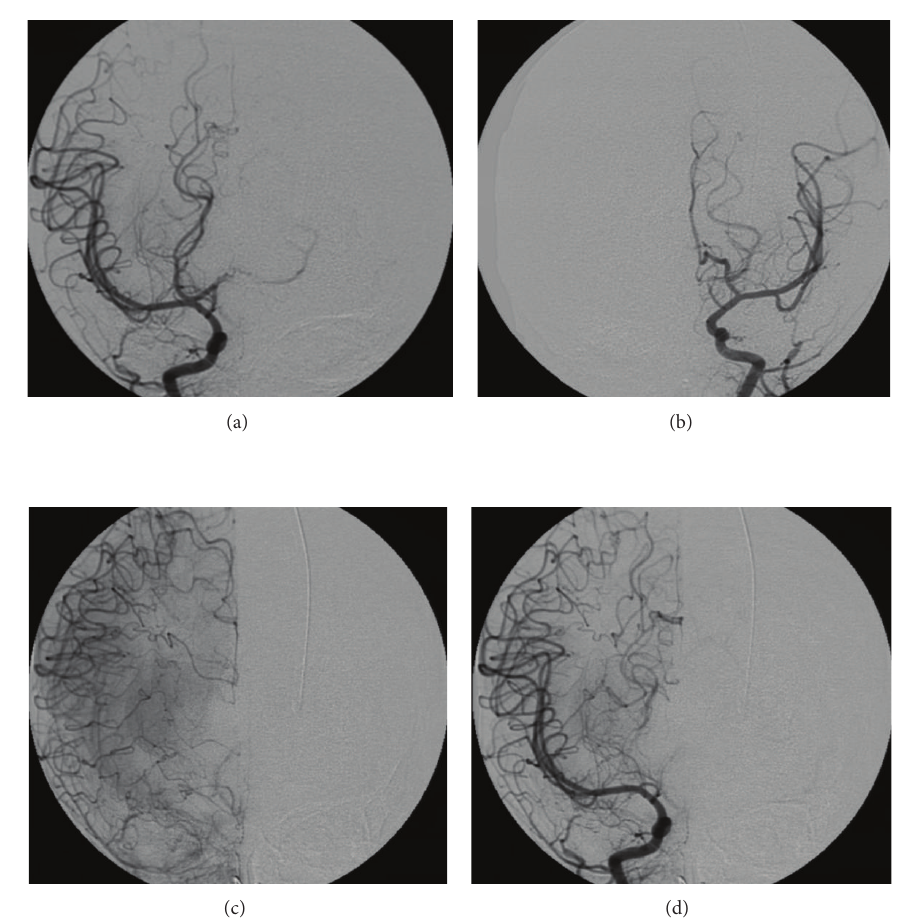
Figure 3: (a) Right internal carotid arteriogram: visualization of the A1 proximal segment. No filling of the A2 segment or the aneurysm. (b) Left internal carotid arteriogram: A1 superiorly and laterally deviated. ((c) and (d)) Right internal carotid arteriogram: right ACA territory vascularization due to leptomeningeal anastomoses between right MCA and PCA.